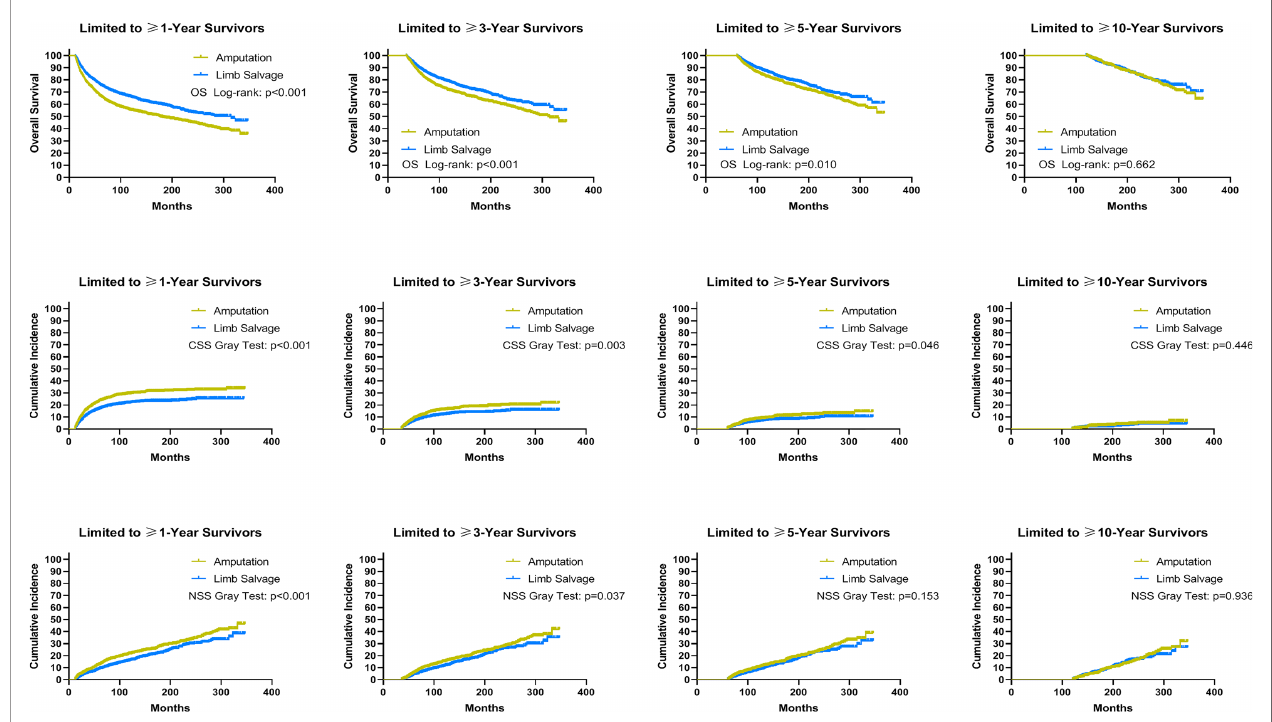
FIGURE 5 | Subgroup analysis: Landmark analyses of overall survival, cancer-speci fi c survival, and non-sarcoma survival for long-term survivors with localized and regional sarcomas in the cohort after PSM. PSM, propensity score-matched patients; OS, overall survival; CSS, cancer-speci fi c survival; NSS, non-sarcoma